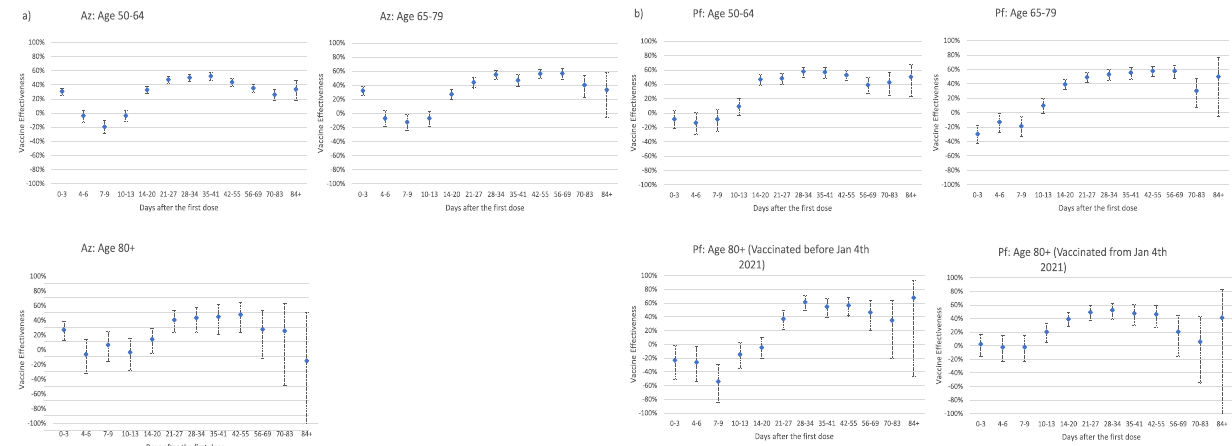
Fig. 2 Adjusted vaccine effectiveness against con fi rmed symptomatic COVID-19 by the interval after vaccination amongst 50 – 64 year-olds, 65 – 79 year-olds and 80 + year-olds with the (a) AZ vaccine and (b) P fi zer-BioNTech BNT162b2 vaccine. a VE against con fi rmed symptomatic COVID-19 after vaccination with AstraZeneca. N = 425,907 people PCR tested. Logistic regression was used to estimate the odds of vaccination in PCR-con fi rmed cases compared with those who tested negative for SARS-CoV-2. Vaccine effectiveness was calculated as 1 minus adjusted odds ratio and is presented as a percentage ±95% con fi dence intervals. b VE against con fi rmed symptomatic COVID-19 after vaccination with P fi zer. N = 384,297 people PCR tested. Logistic regression was used to estimate the odds of vaccination in PCR-con fi rmed cases compared with those who tested negative for SARS-CoV-2. Vaccine effectiveness was calculated as 1 minus adjusted odds ratio and is presented as a percentage ±95% con fi dence intervals. Table 3 Geometric mean responses and the geometric mean ratio of responses following dose 2, by the vaccine, interval compared with convalescent sera. N Geometric mean response Vaccine Days Time since dose Geometric mean ratio of between doses 2, days (95% CI)* responses from